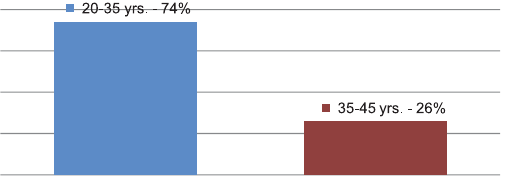
FIGURE 2. Distribution of respondents according to